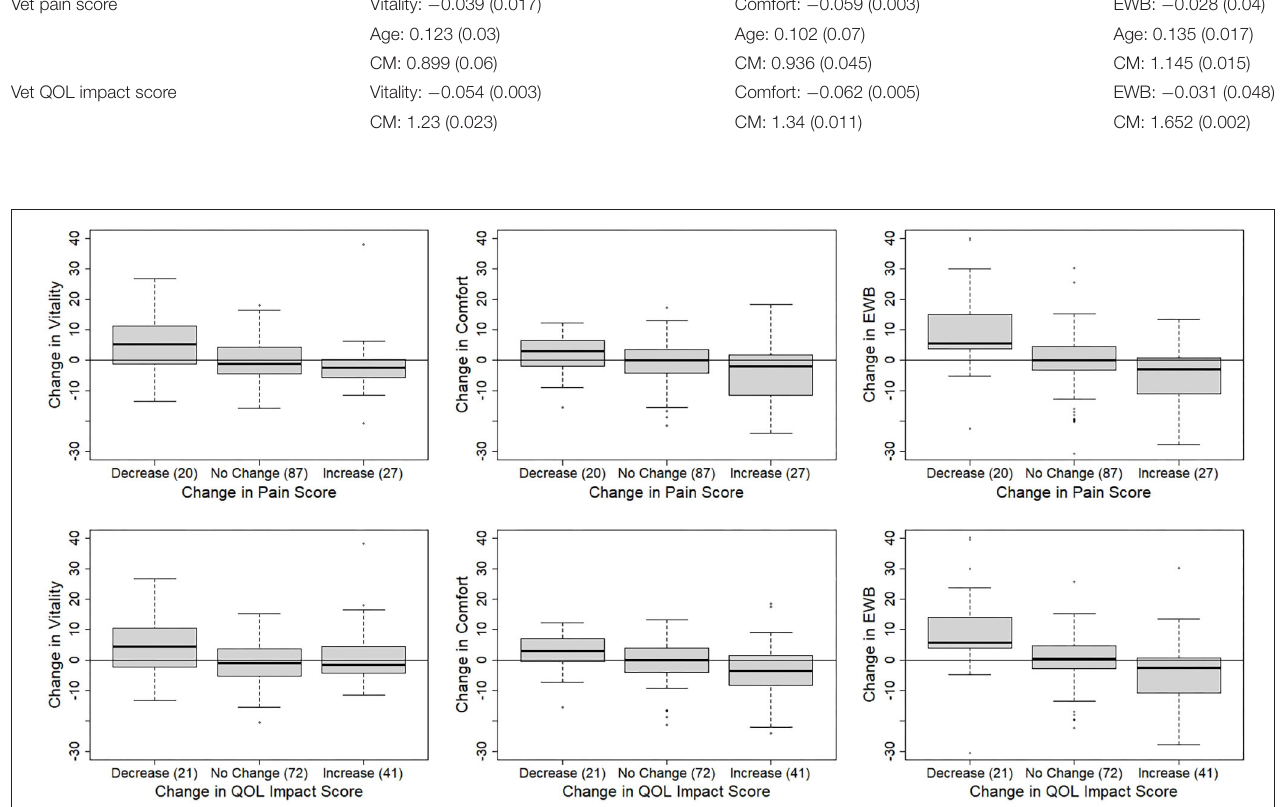
FIGURE 3 | Boxplots of change in the three health related quality of life (HRQL) domain scores according to change in 134 vet-assessed quality of life (QOL) impact and pain scores from 74 cats.